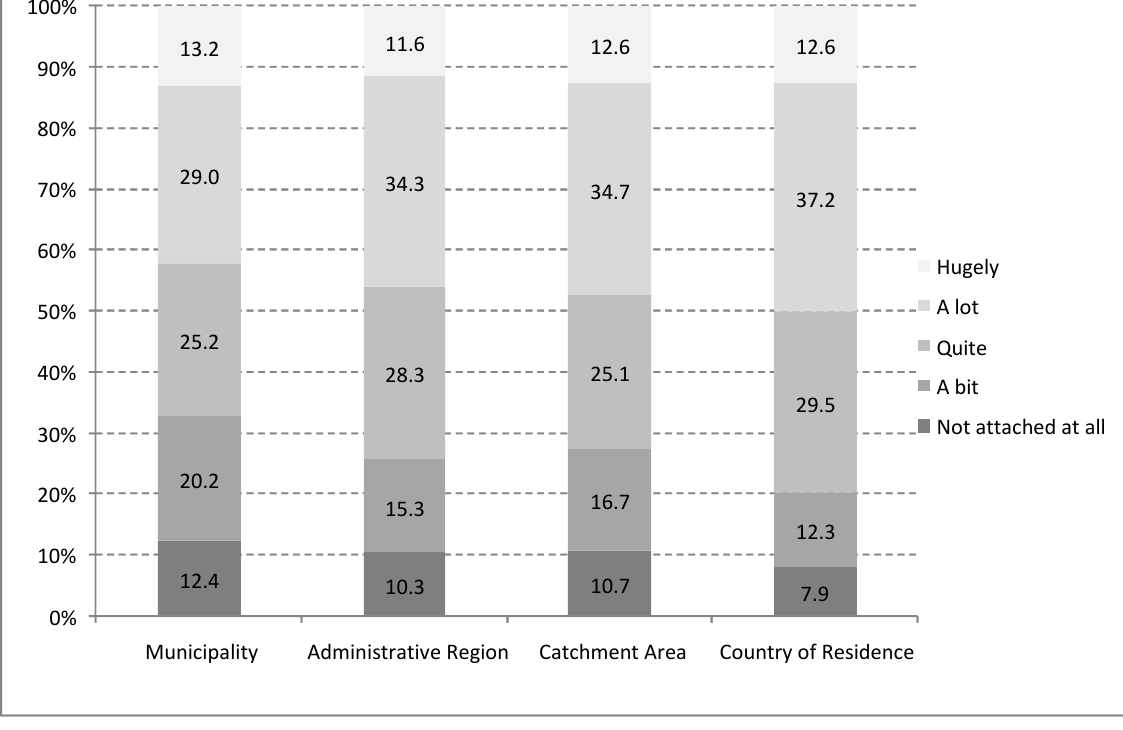
Figure 1. The Belgian–Luxembourgish cross-border workers’ attachment to several territorial entities Source : Cross-border survey 2003, Ceps/Instead (N Belgium =